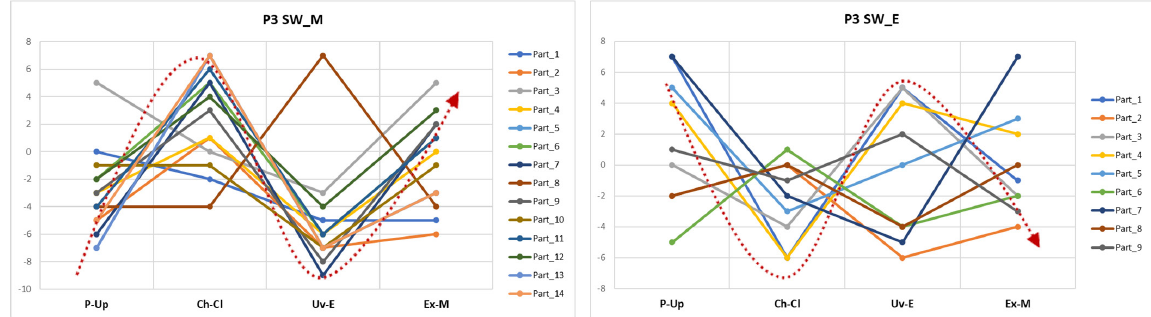
Figure 15: Contrast differences analysis at stop number P3 from collaborators taking part in SW_M (14 participants) and SW_E (9 partici- pants) soundwalks. The dotted red line indicates change tendency from “annoying-chaotic-eventful” soundscape (left) in the morning to